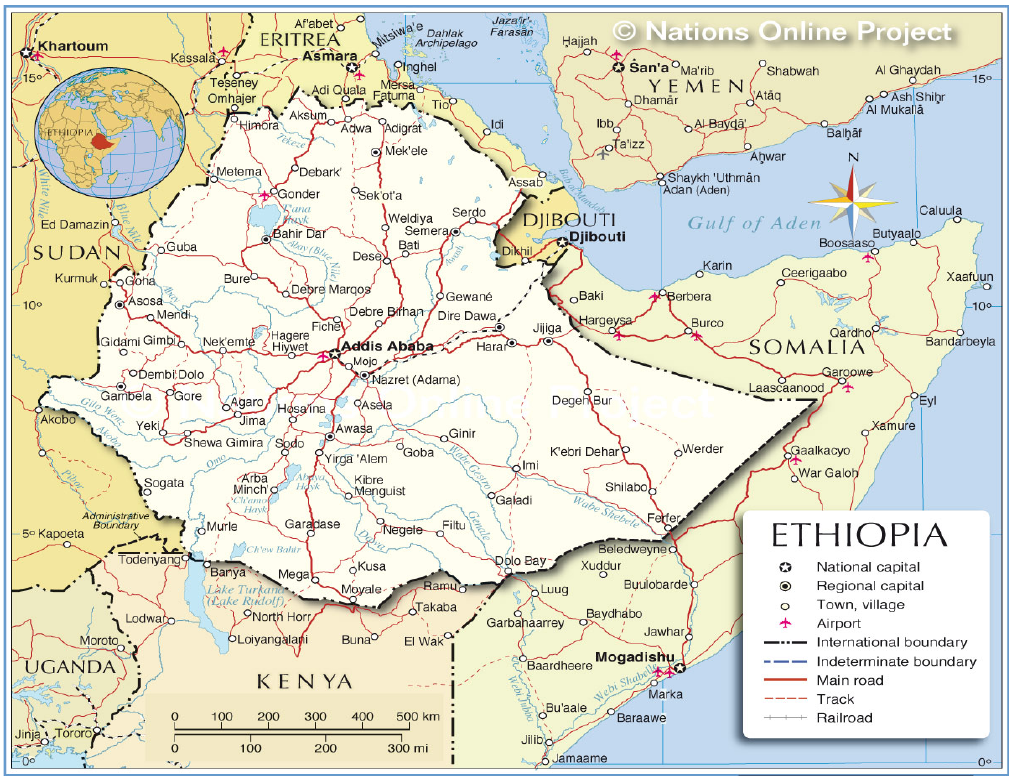
Figure 1: Map of